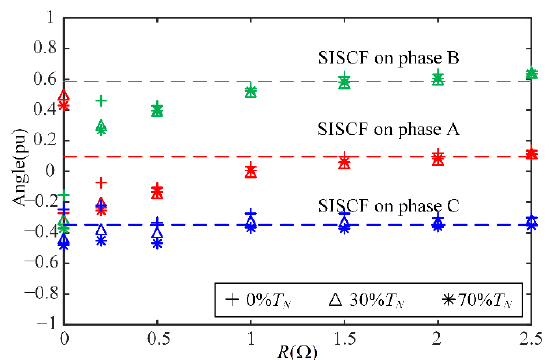
Figure 16. Park vector trajectory ellipse long axis tilt angle of experimental data.